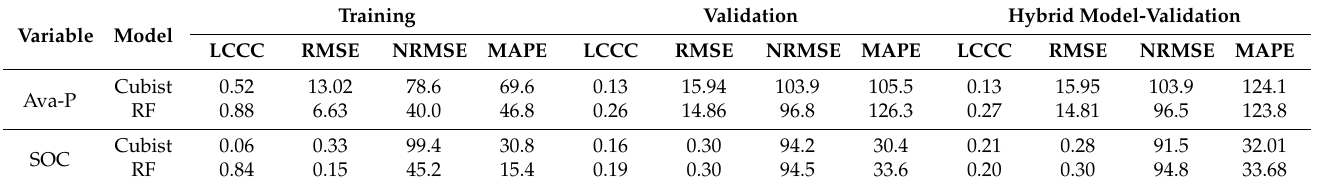
Table 4. Comparisons of the accuracy of cubist and random forest models for calibration and validation dataset, additionally accuracy of hybrid models for the validation